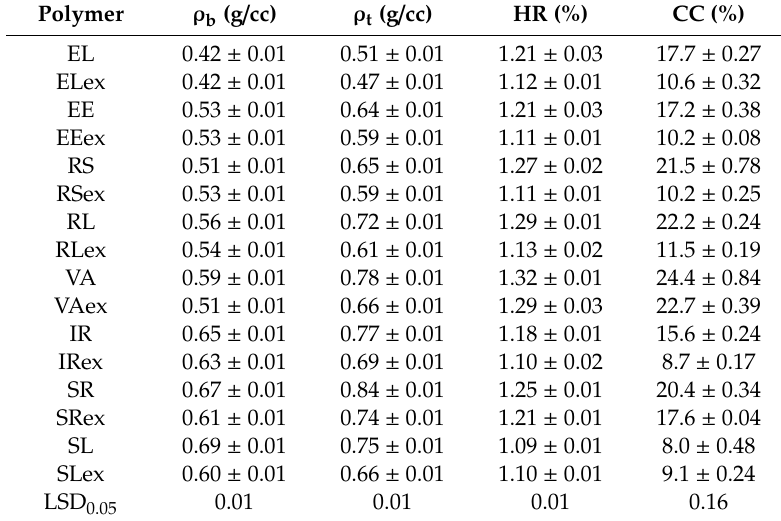
Table 5. Results of powder packing properties (mean values ± SD, n = 3, LSD 0.025